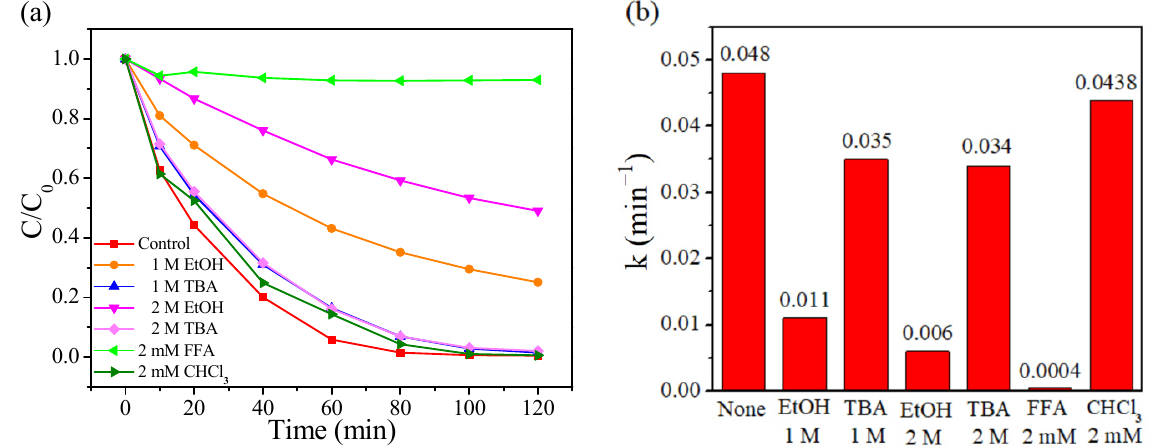
Figure 5. ( a ) Effects of different capture agents for RhB degradation in the CoAl 2 O 4 -500/PMS system, ( b ) comparison of the reaction rate constant under different capture agents.